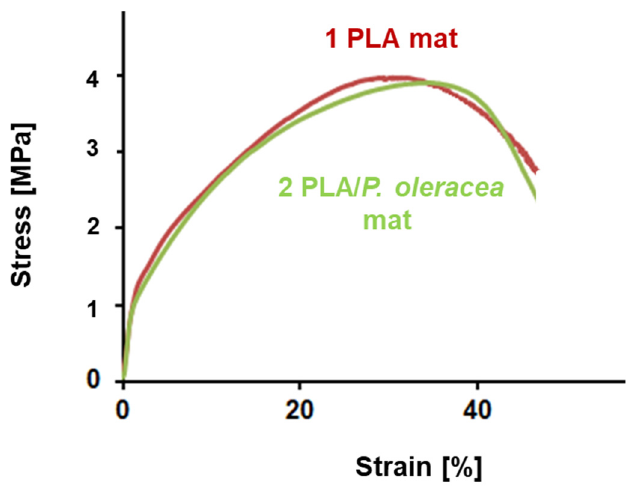
Figure 4. Stress–strain curves of: electrospun PLA mat and PLA/ P. oleracea mat.